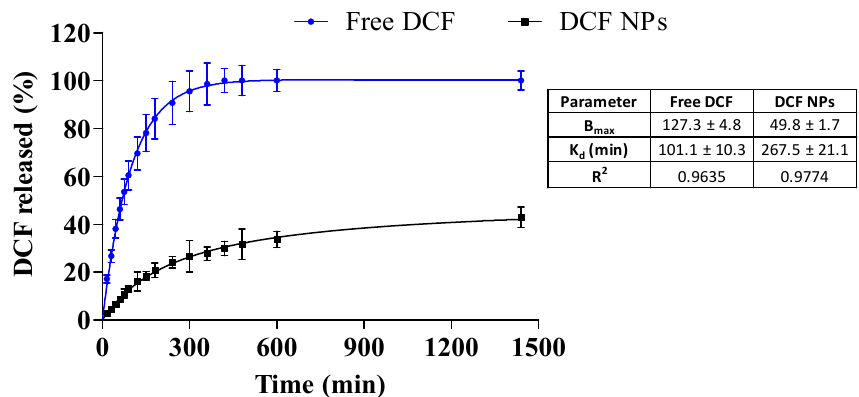
Figure 4. In vitro release profile of DCF NPs vs. free DCF carried out for 24 h and adjustment to a hyperbola equation.